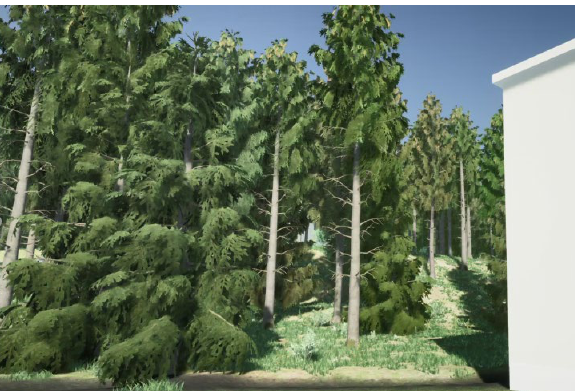
Figure 7 . Vegetation generated through the UE Procedural Foliage Spawner. Pedestrian